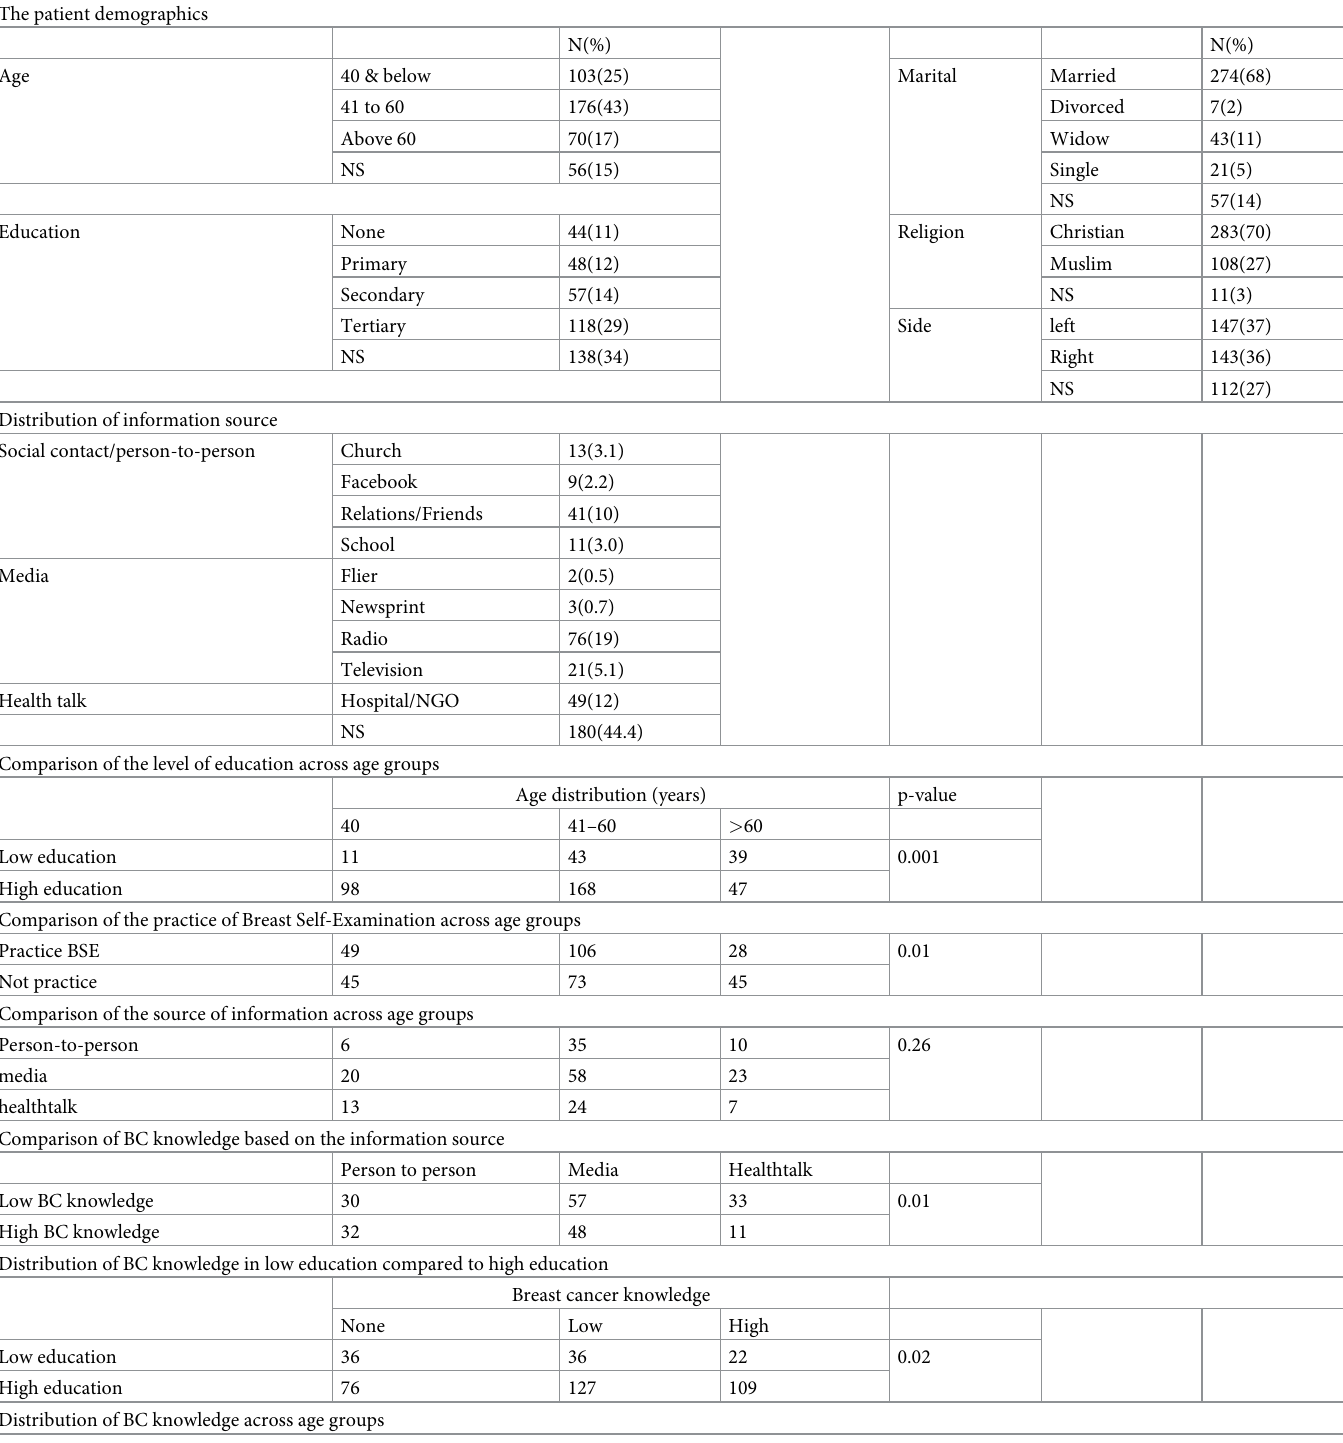
Table 1. The patient demographics, distribution of information source, the comparison of level of eduction, practice of breast self-examination and information across age groups, comparison of breast cancer knowledge based on information source and education and distribution of BC knowledge across age groups. The patient